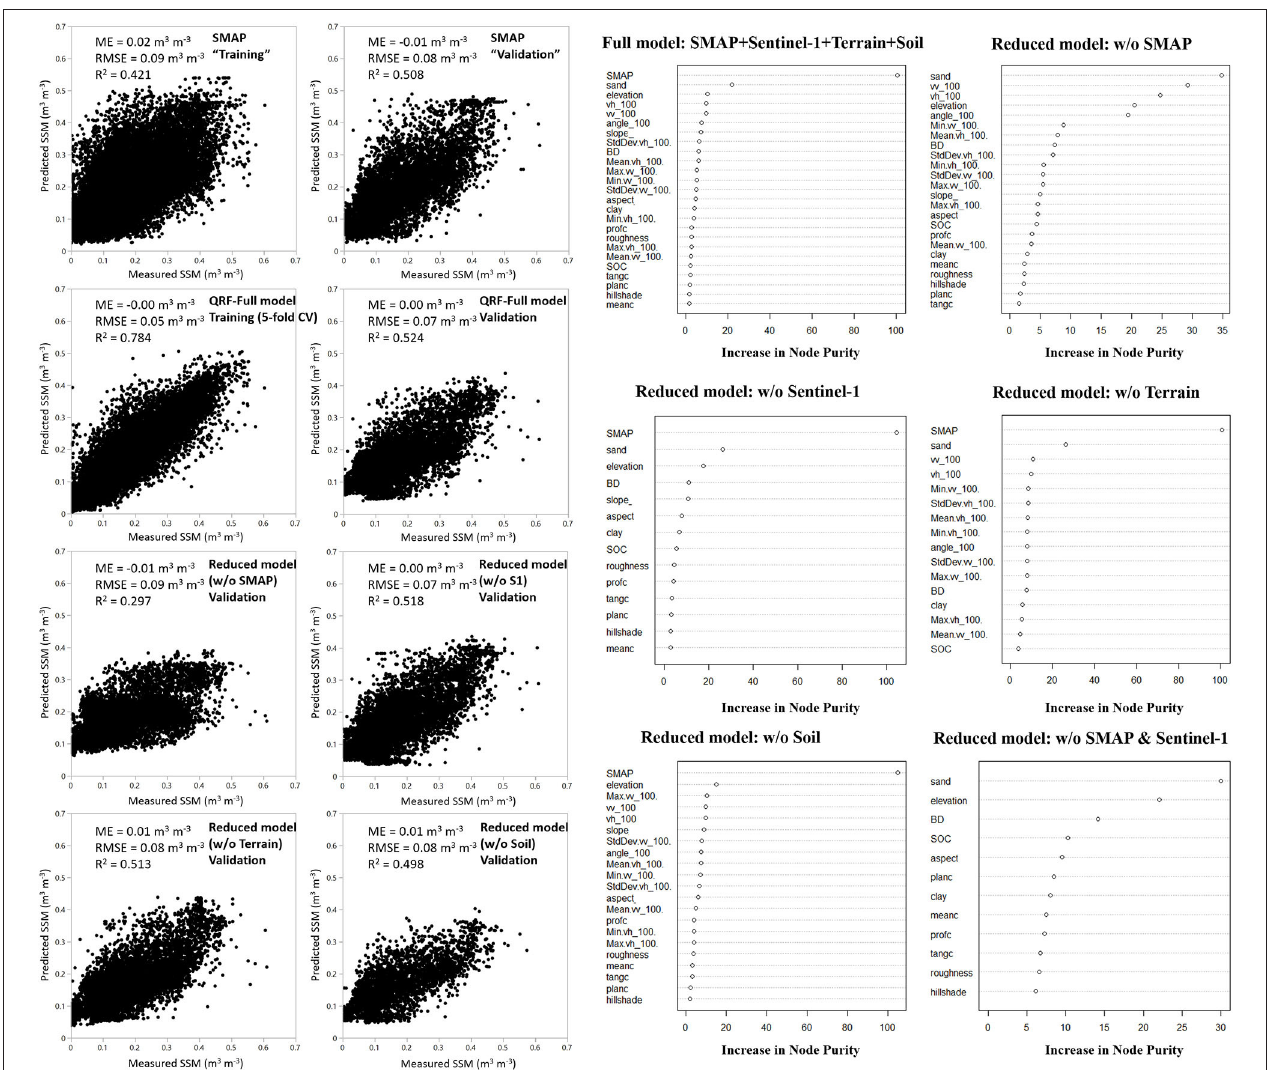
FIGURE 3 | Comparison of the performance and variable importance of quantile random forest (QRF) models on regional- and continental- scale training (70% of the stations from all networks) and validation (remaining 30% stations from all networks) datasets. The models were established using different combinations of input covariates. R2, coefficient of determination; ME, mean error; RMSE, root mean squared error.